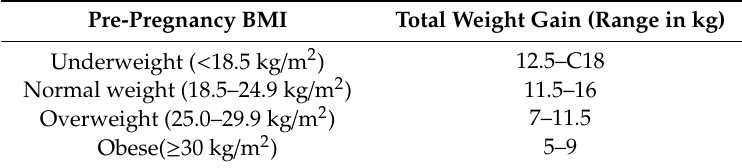
Table 1. Recommendations for total weight gain during singleton pregnancy.